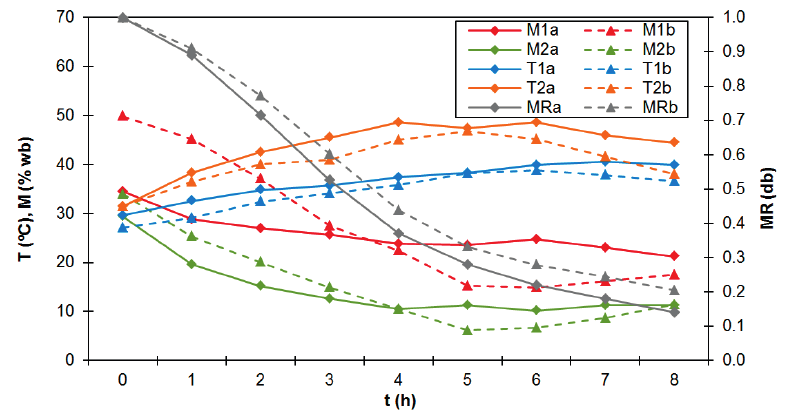
Figure 14. T, M and MR variation of OP for two situations.